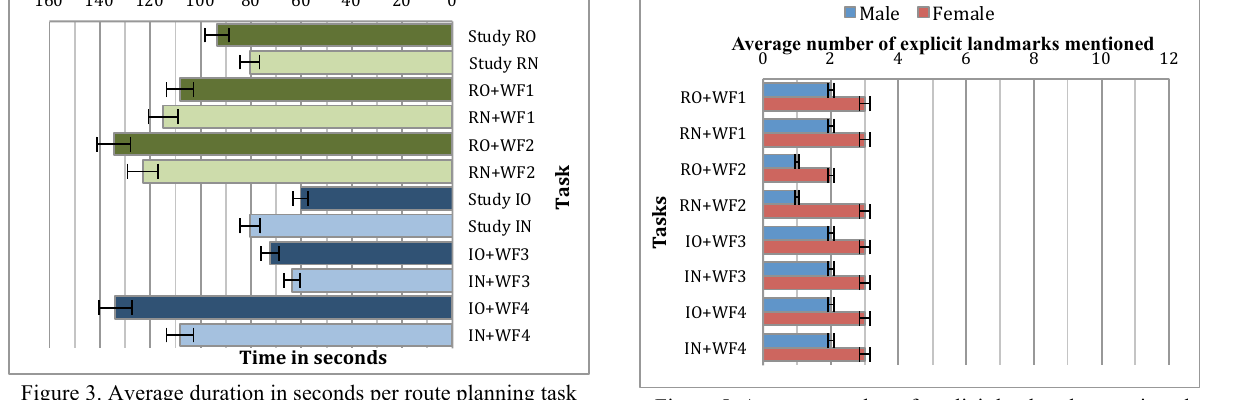
Figure 5. Average number of explicit landmarks